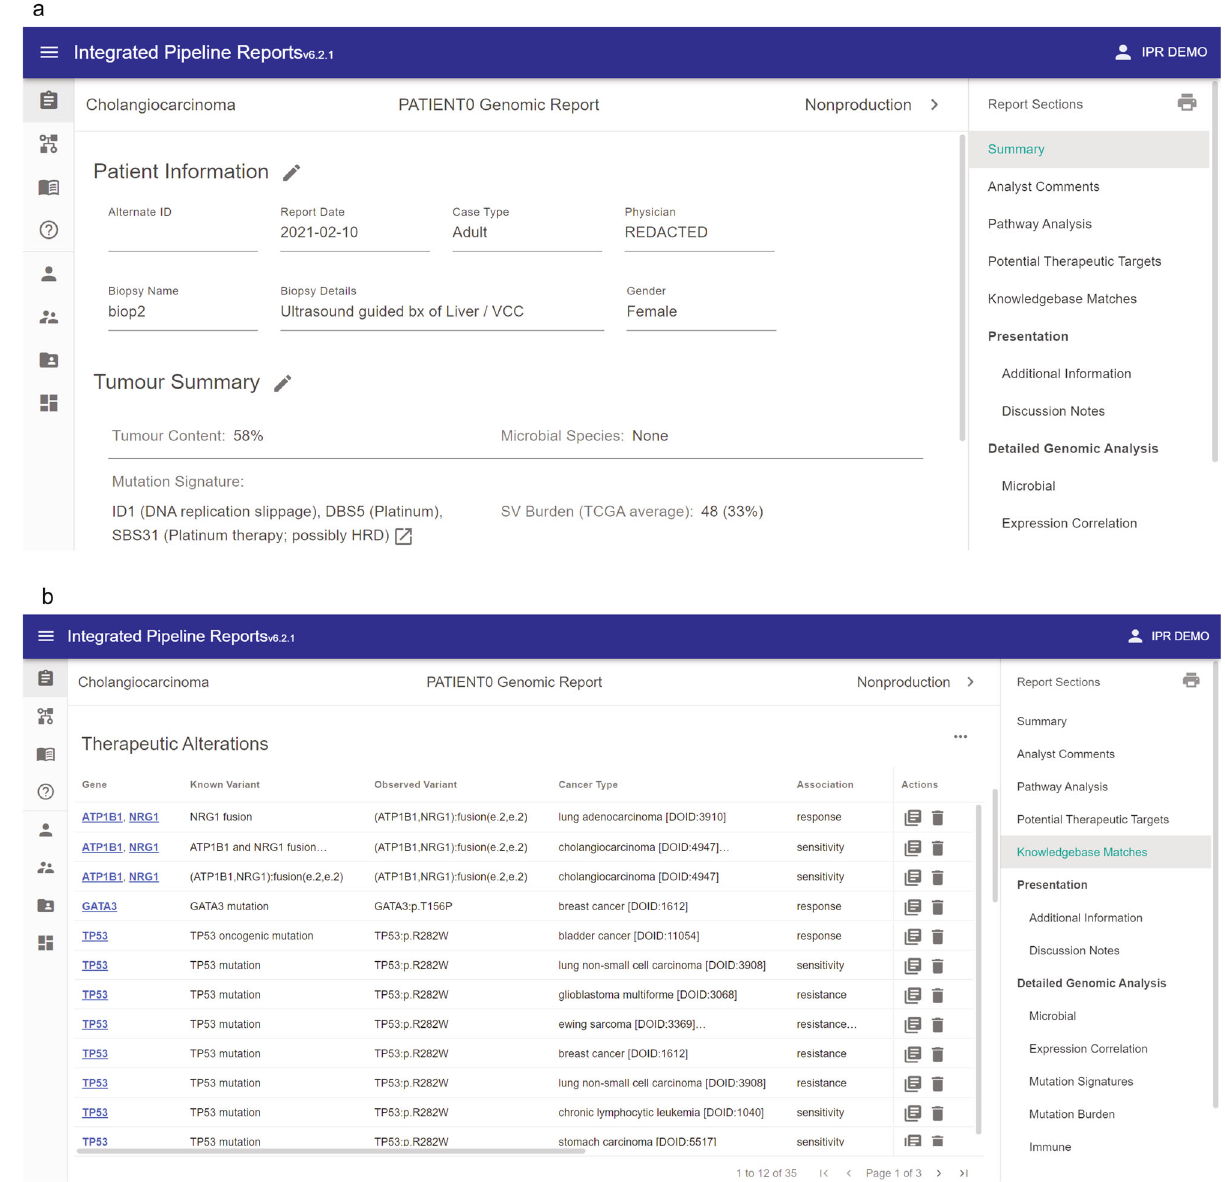
Fig. 2 Integrated Pipeline Reports (IPR) web interface. ( a ) The report front page of an example report displaying patient metadata and a summary of tumour characteristics and fi ndings. ( b ) The annotations collected from GraphKB are listed in the knowledge base matches section of the generated report with links from each match back to its corresponding statement in